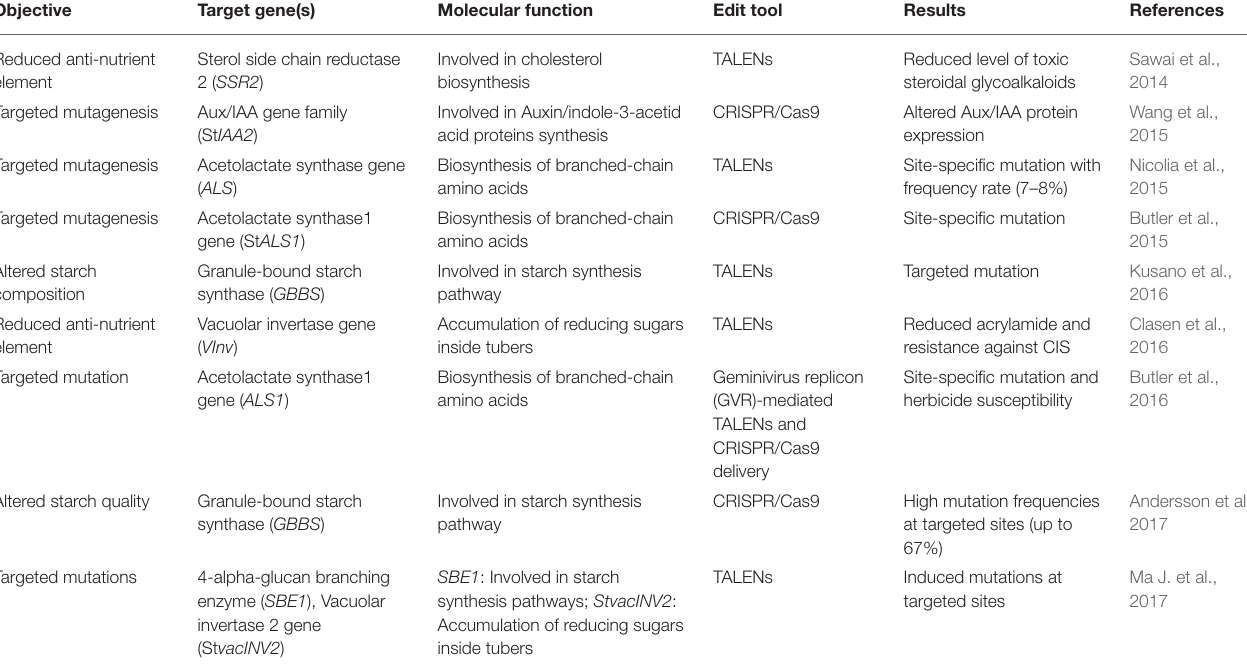
TABLE 2 | Applications of some new breeding technologies for potato trait